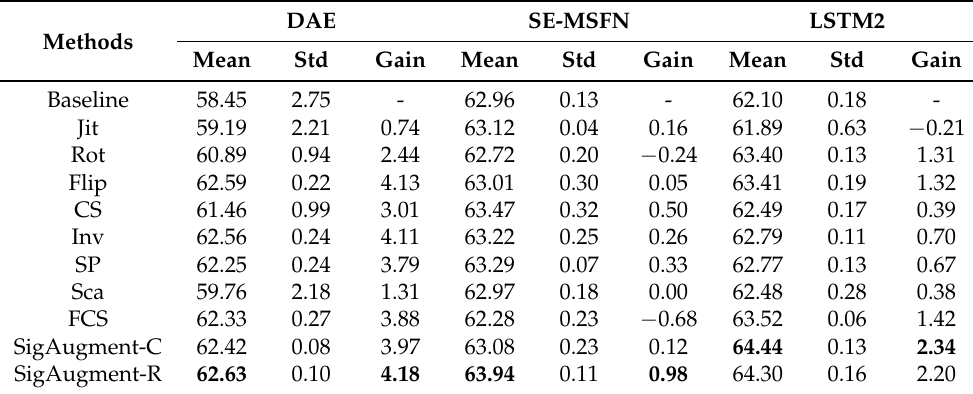
Table 3. The average recognition accuracy (%) of the baseline models on the 2016A dataset using various data augmentation methods and the gain (%) when compared to no data augmentation. The top1 average accuracy and gain have been highlighted.